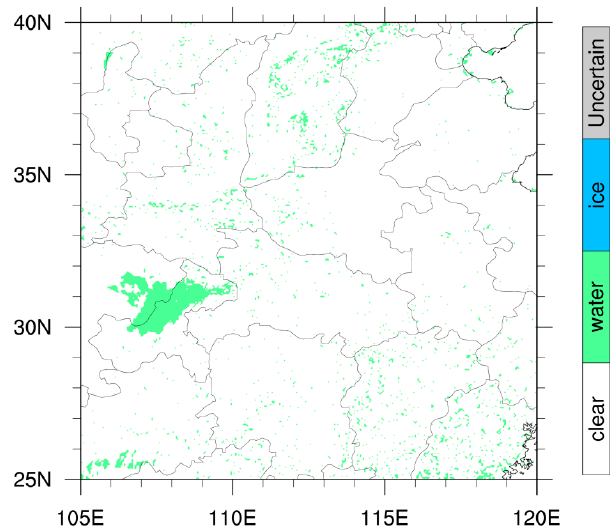
Figure 2. Cloud locations in the simulation area.